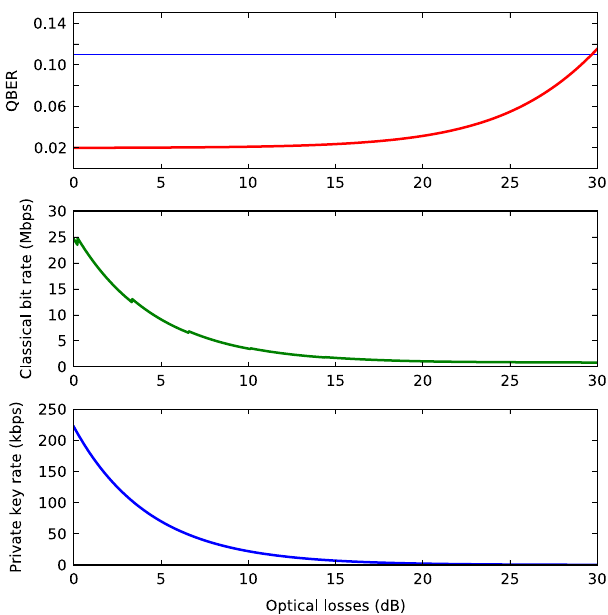
Fig. 7 Private key rate achievable as a function of optical losses, and the corresponding classical communication overhead that would be required for continuous steady state key production, for the simulated BBM92 link in the previous fi gure (288.15 K). The highest QBER with which QKD can be performed securely here is 0.11 ( horizontal blue line